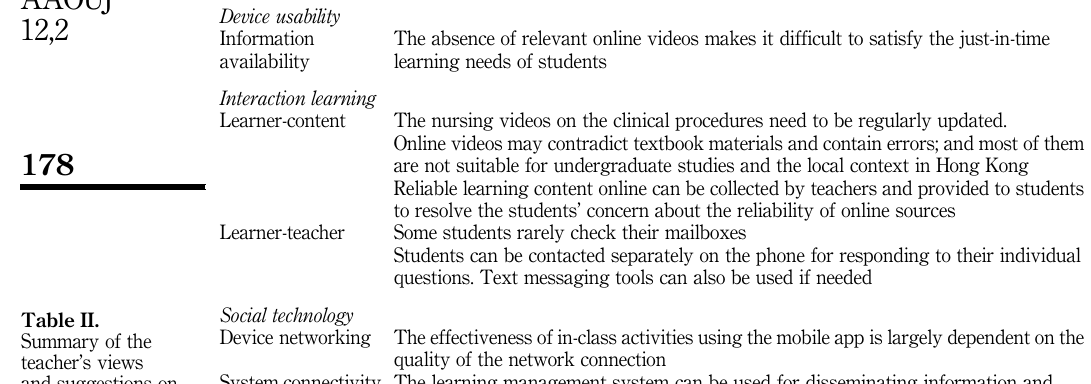
Table II. Summary of the teacher ’ s views and suggestions on mobile